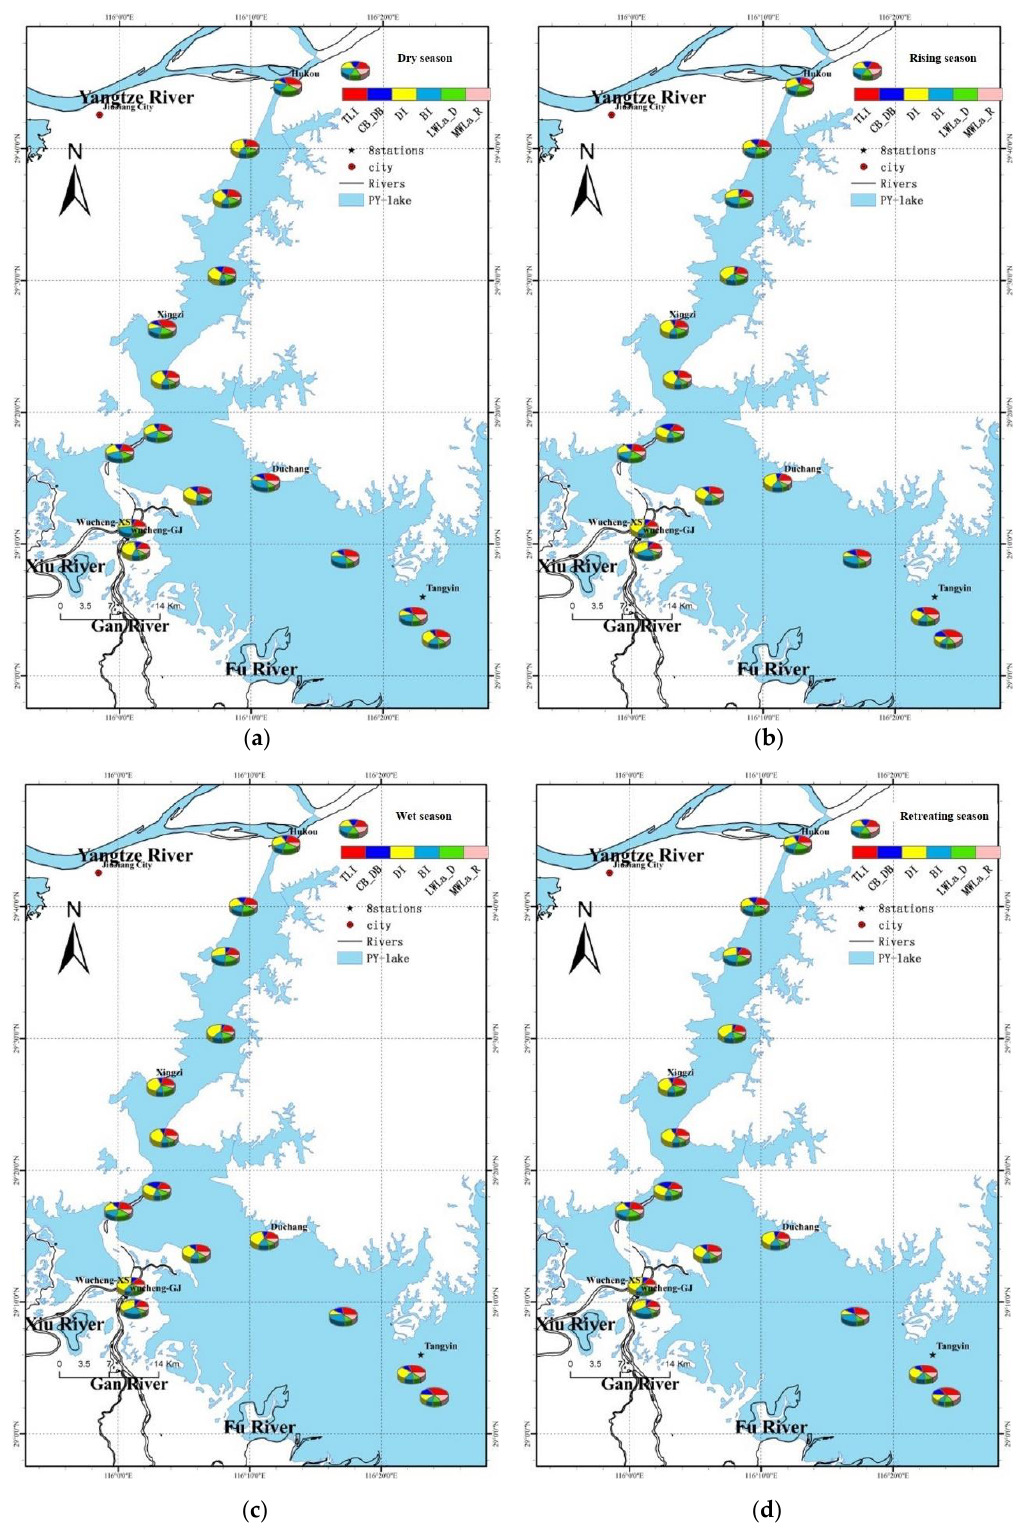
Figure 6. Aquatic ecosystem assessment weights of Poyang Lake in four seasons in 2013 ( a ): dry season, ( b ): rising season; ( c ): wet season; and ( d ): retreating season. TLI, trophic state index; DI, diversity index of macrozoobenthos; CB/DB, ratio of cyanobacterial biomass to diatom biomass; LWLa-D, lowest water level anomaly during dry season; BI, biotic index; MWLa-R, mean water-level anomaly during rising season).